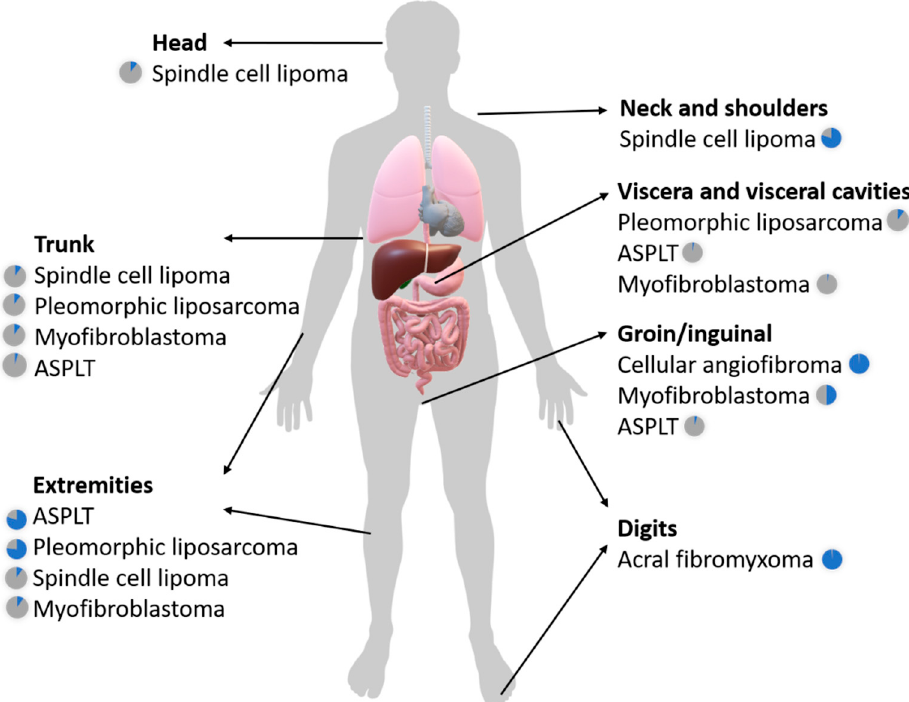
Figure 1. Anatomical distribution of the different RB1 -deleted mesenchymal neoplasms. Pie charts next to the tumor names represent the frequency of a given tumor occurring in that specific location (blue pie segment). ASPLT—Atypical spindle cell/pleomorphic lipomatous tumor.